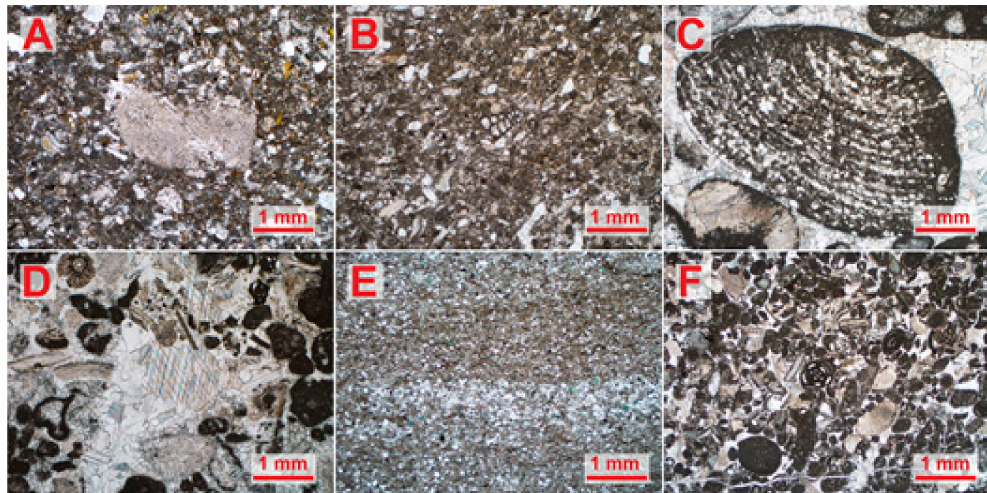
Figure 6. Selection of thin sections from landslide deposits ( A ) Drusberg, sample no: SW-1. ( B ) Drusberg, SW-2. ( C ) Schrat- tenkalk, SW-3. ( D ) Schrattenkalk, SW-4. ( E ) Helvetischer Kieselkalk, SW-7. ( F ) Schrattenkalk, SW-9. See also